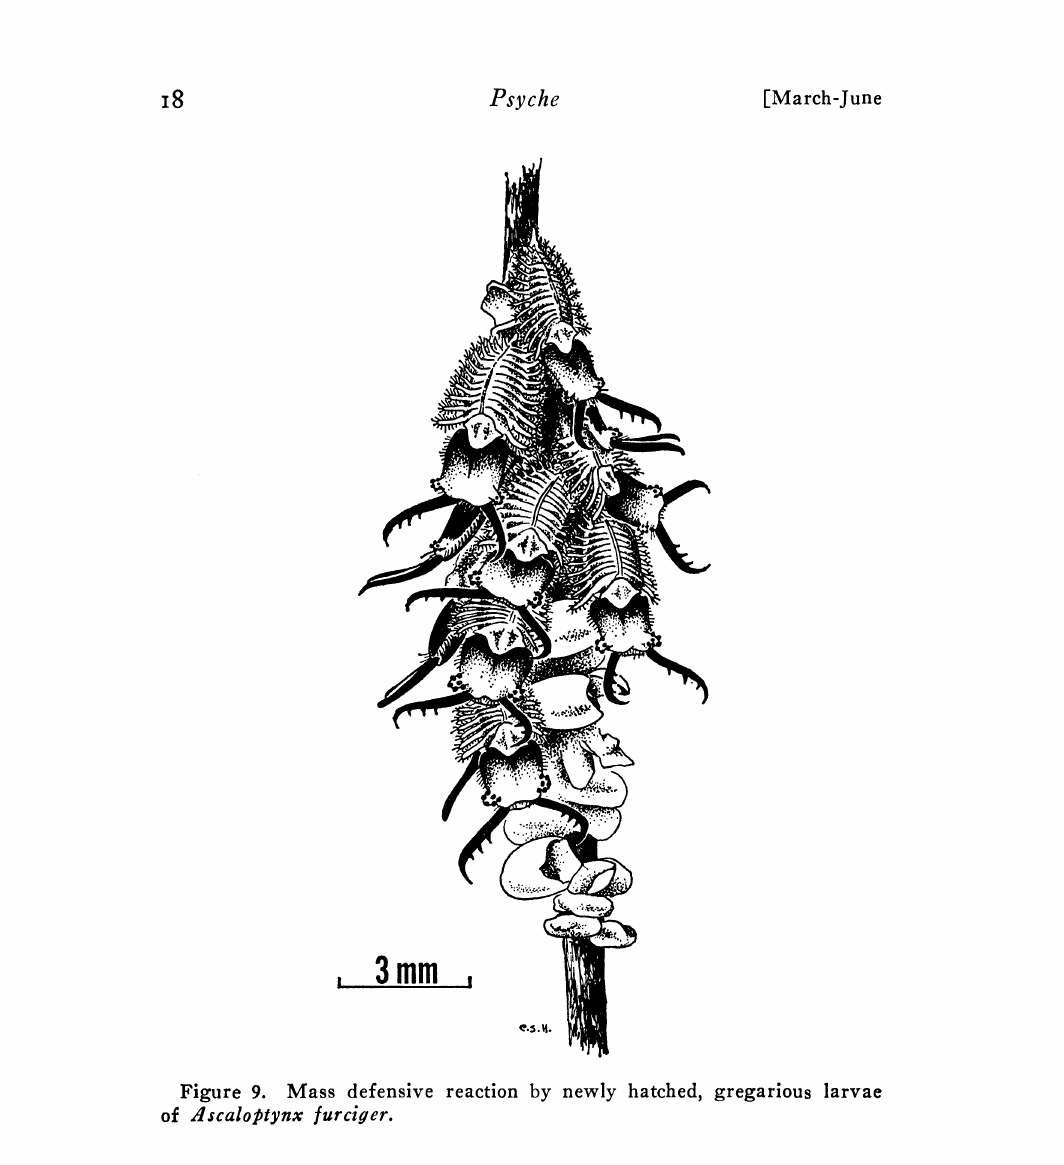
Figure 9. Mass defensive reaction by newly hatched, gregarious larvae of ztscaloptynx